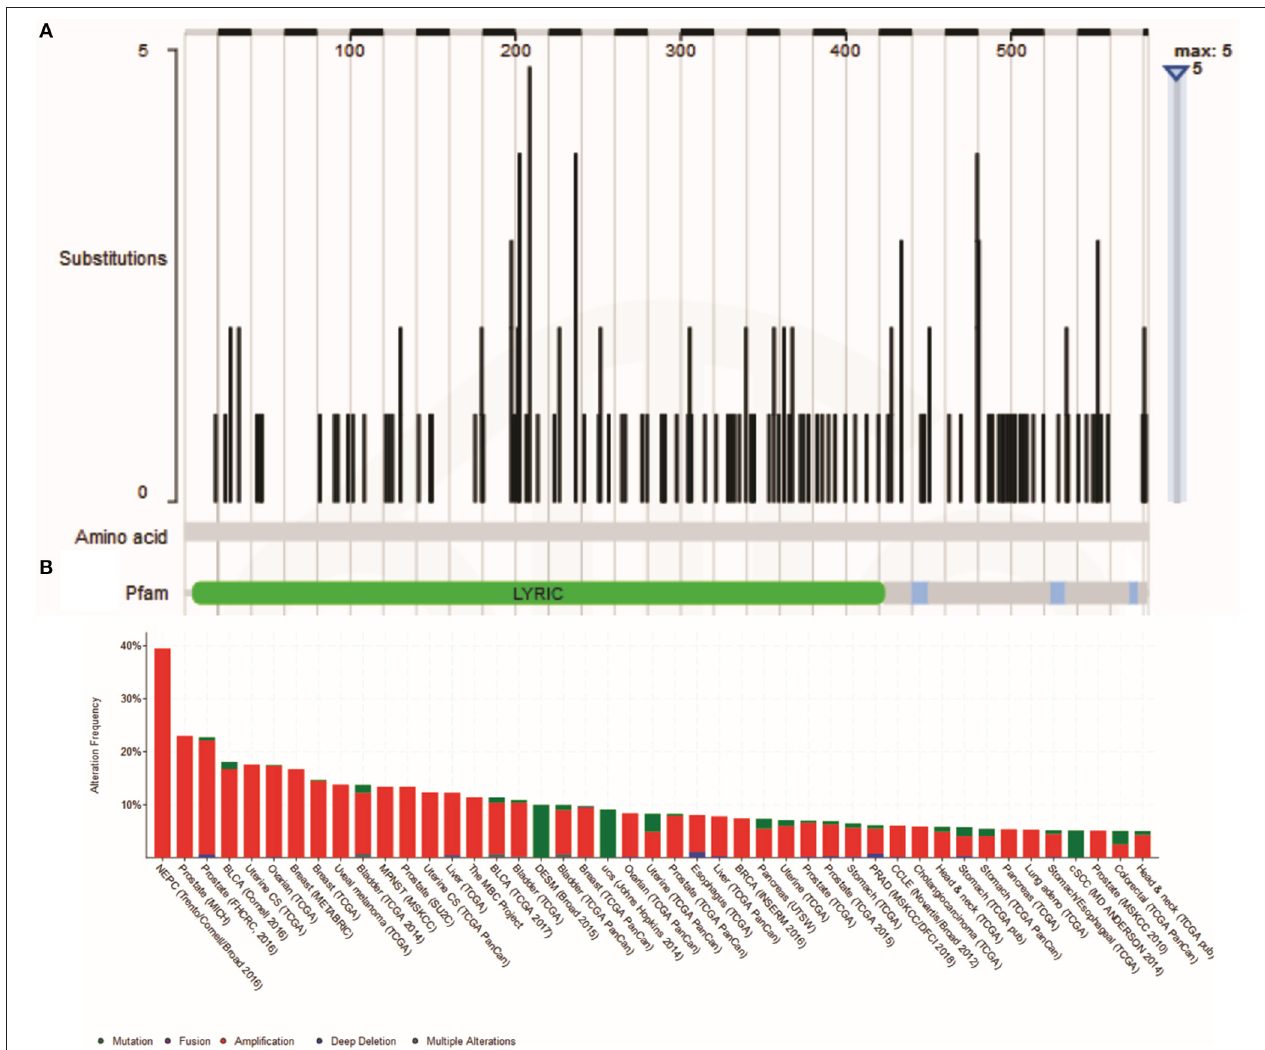
FIGURE 1 | (A) Cancer-related Metadherin mutations (https://cancer.sanger.ac.uk/cosmic) (B) Metadherin mutations in many cancer types. The results was generated by the TCGA Research Network